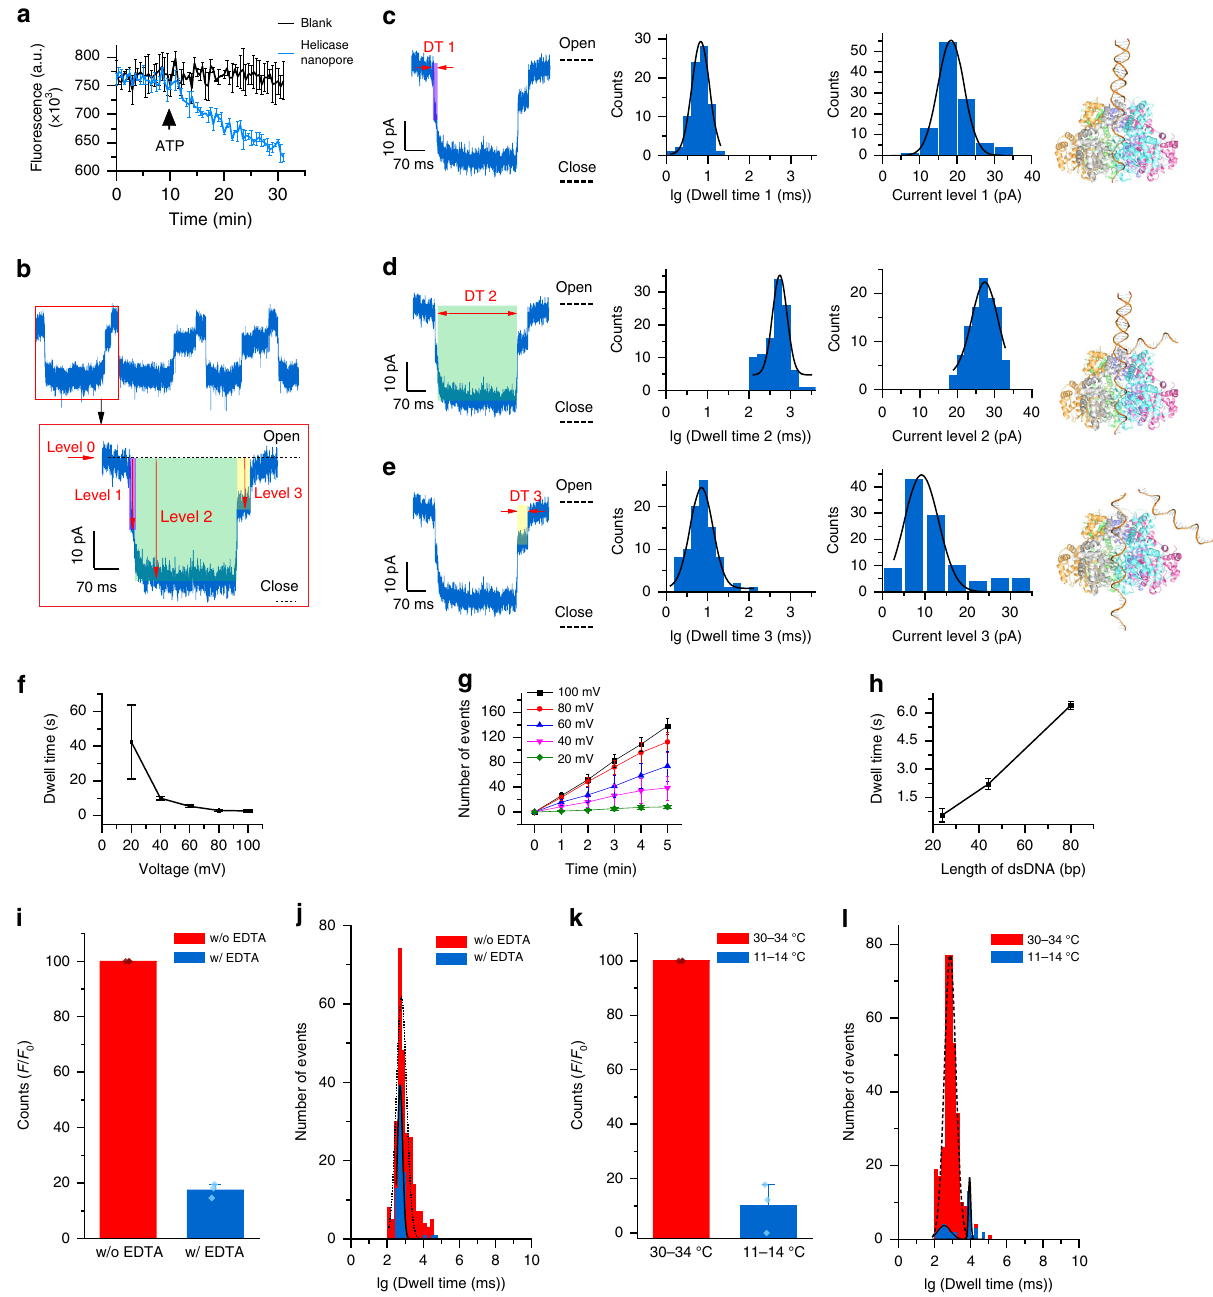
Fig. 3 Single-molecule dynamics of helicase nanopore unwinding dsDNA. a Fluorescence quenching assay showing the unwinding process of dsDNA after the addition of ATP ( n = 3). b Continuous signals caused by dsDNA unwinding through a helicase nanopore embedded in a lipid bilayer membrane (buffer condition: PBS, pH 7.0, under + 120 mV, n = 223 from 3 trials). c – e Typical current stages in a dsDNA unwinding event (left) and the pattern diagram of these three stages (right), with analysis of their current steps and dwell times (middle) (buffer condition: PBS, pH 7.0, under + 120 mV c – e : n = 105). f The dependency relationship of unwinding time through the helicase nanopore with bias voltage (24 bp dsDNA) (buffer condition: PBS, pH 7.0, + 100 mV ( n = 48), + 80 mV ( n = 75), + 60 mV ( n = 58), + 40 mV ( n = 55), + 20 mV ( n = 16)). g The number of cumulative dsDNA translocation events increased with the elongation of time at different voltage (buffer condition: PBS, pH 7.0, n = 3). h The unwinding time on the membrane with different lengths of substrate DNA under a bias voltage of + 120 mV (buffer condition: PBS, pH 7.0, n = 3). i , j The number of unwinding and translocation events decreased when the helicase nanopore activities was inhibited by EDTA chelation of Mg 2 + in electrolyte (buffer condition: PBS, pH 7.0, i : n = 3; j : n (with EDTA) = 258, n = 72). k , l The number of unwinding and translocation events decreased when the helicase nanopore motor activities inhibited by lower (without EDTA) temperatures (buffer conditions: PBS, pH 7.0, n = 3; n (30 – 34°C) = 333, n (11 – 14°C) = 76). Error bars in the fi gure represented the standard deviation between independent experiments. Source data are provided as a Source Data fi